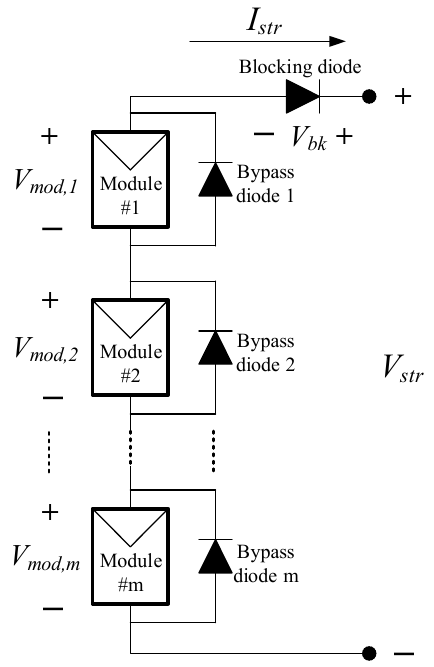
Figure 2. A photovoltaic (PV) string with m modules connected in series and protected by the bypass and blocking diodes.